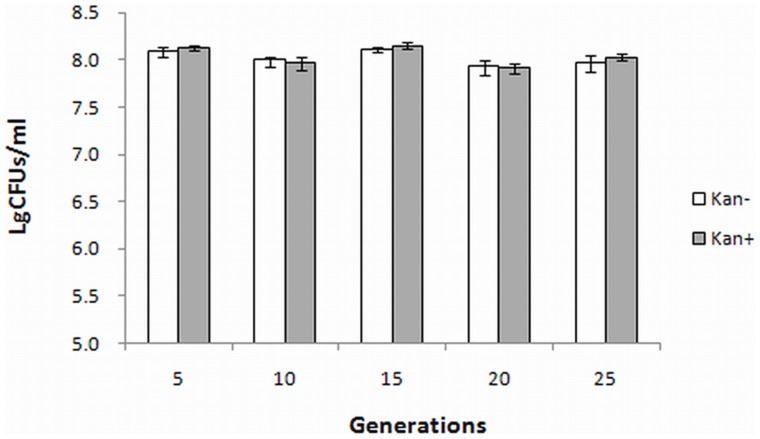
Detection of the genetic stability of N. gonorrhoeae Rmp deletion mutant strain.Same amounts of every 5 generations of culture products subcultured in ordinary culture medium were inoculated in FB liquid culture media with and without kanamycin for counting (n = 5).